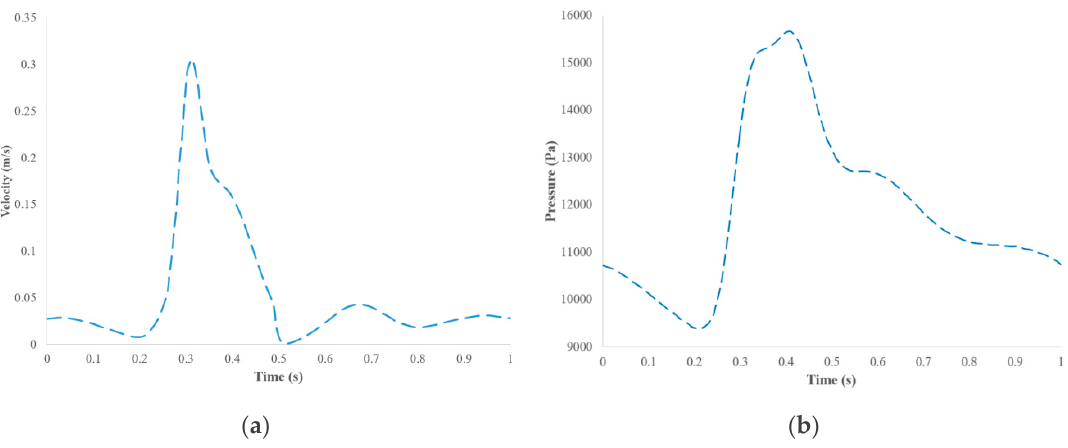
Figure 4. ( a ) Inlet velocity and ( b ) outlet pressure waveform.